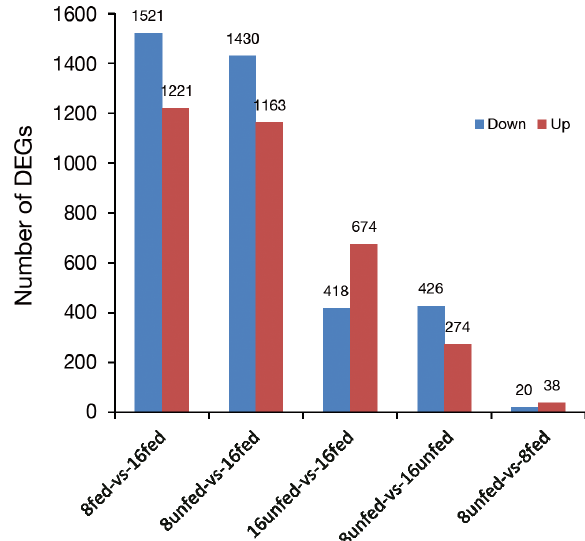
Fig. 3. Comparison of up-regulated and down-regulated dif- ferentially expressed gene (DEG) numbers between differ- ent groups of yellow drum subjected to cold and starvation